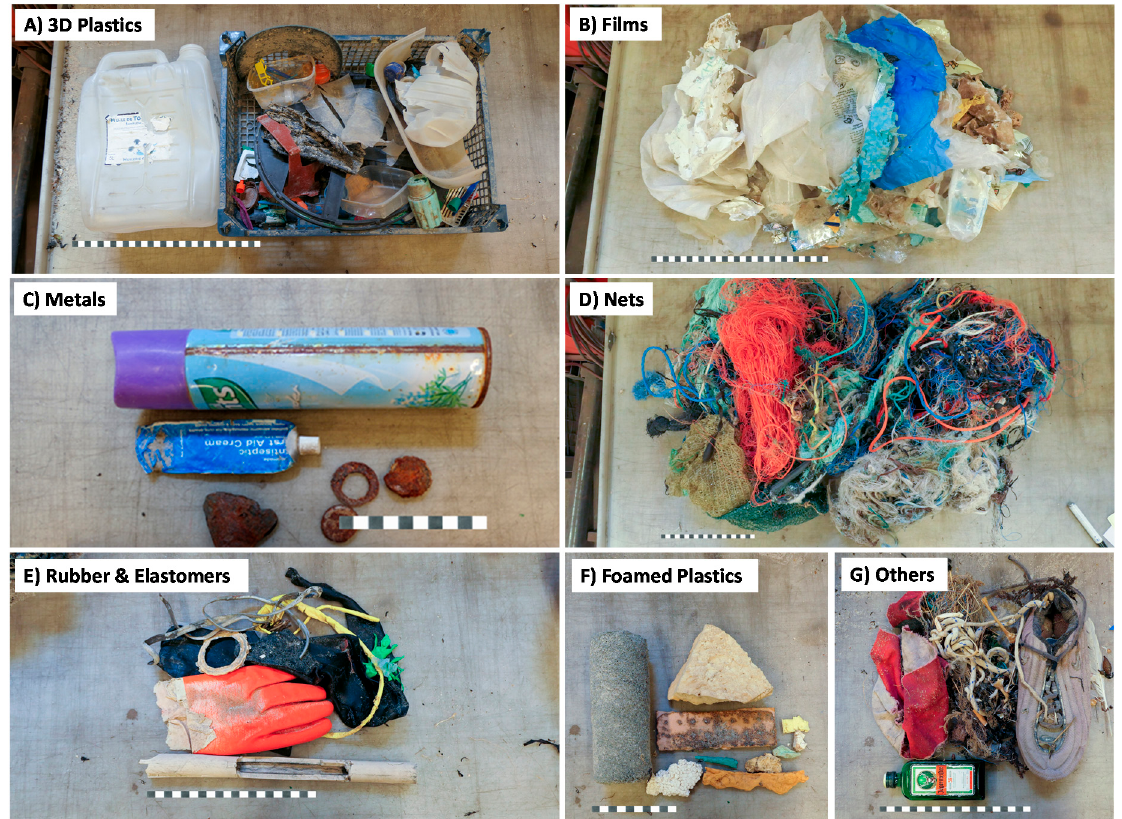
Figure 3. ML fractions Sylt: ( A ) 3D Plastics; ( B ) Films; ( C ) Metals; ( D ) Nets; ( E ) Rubbers & Elastomers; ( F ) Foamed Plastics and ( G ) Others. The scale amounts to 1 cm per section (Picture: Jacqueline Plaster, Johann Hee).